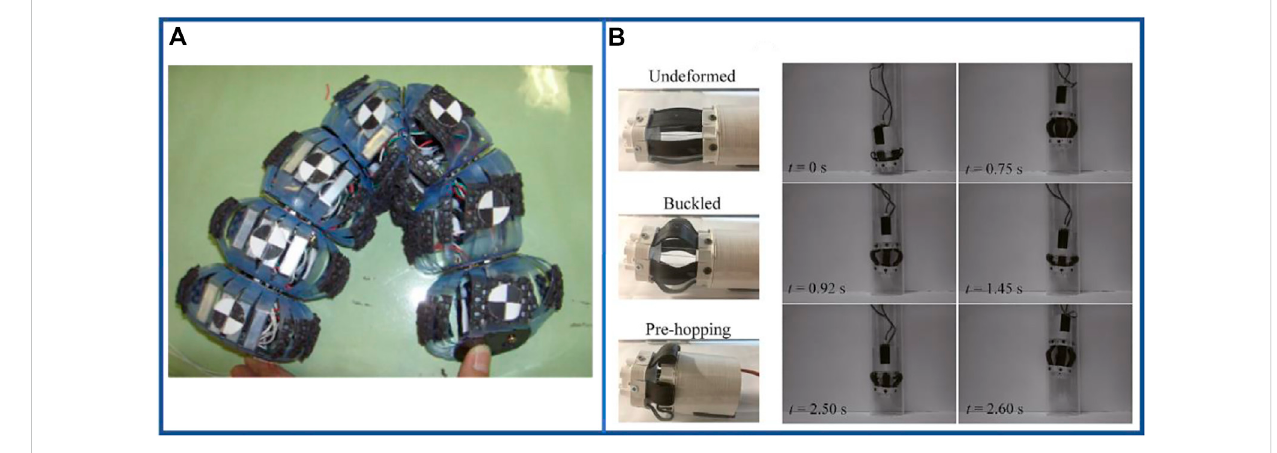
FIGURE 11 Examples of direct motor-driven multi-segment earthworm-inspired soft robots. (A) Diagram of angle control and bending of robot segment (Omori et al., 2008). Reproduced from Ref. (Omori et al., 2008). with permission. (B) Three states of single-section robot and representative images illustrate vertical hopping process of single-section robot in continuous hopping (Yeh et al., 2020). Reproduced from Ref. (Yeh et al., 2020). with permission.